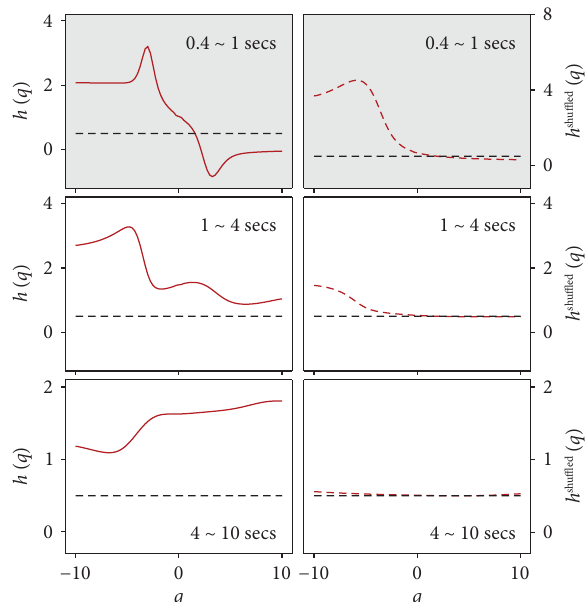
Figure 5: Frequency recordings are multifractal and anticorrelated on short and correlated on longer time scales. We plot the gen- eralized Hurst exponent h ( q ) of power-grid frequency recordings from the Lisbon recording in Continental Europe at diferent time scales, from top to bottom: 0 . 4 ∼ 1s, 1 ∼ 4s, and 4 ∼ 10s. Te smallest time scales show a nonconstant exponent h ( q ) , which points to the existence of a large number of degrees of freedom in the system. As the time scales become larger, the system gets progressively more ordered, as fuctuations are quenched by the strong synchrony in the system. At a time scale of 4 ∼ 10s the shufed grid frequency recording becomes indistinguishable from noise ( h ( q ) � 0 . 5 )